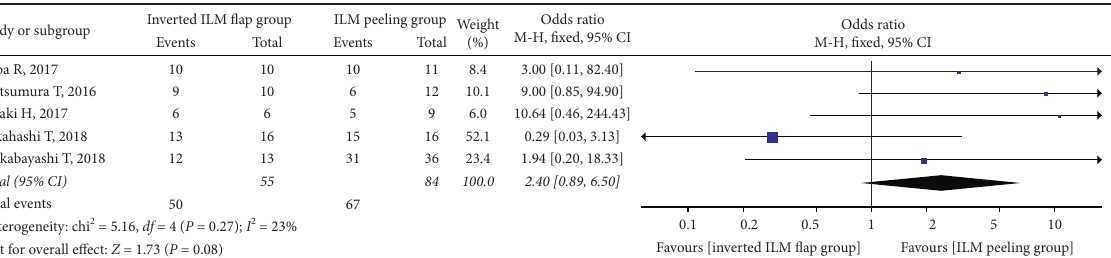
Figure 4: Forest plot comparing retinal reattachment rate between inverted ILM flap and ILM peeling groups at 6 months after surgery. ILM � internal limiting membrane.